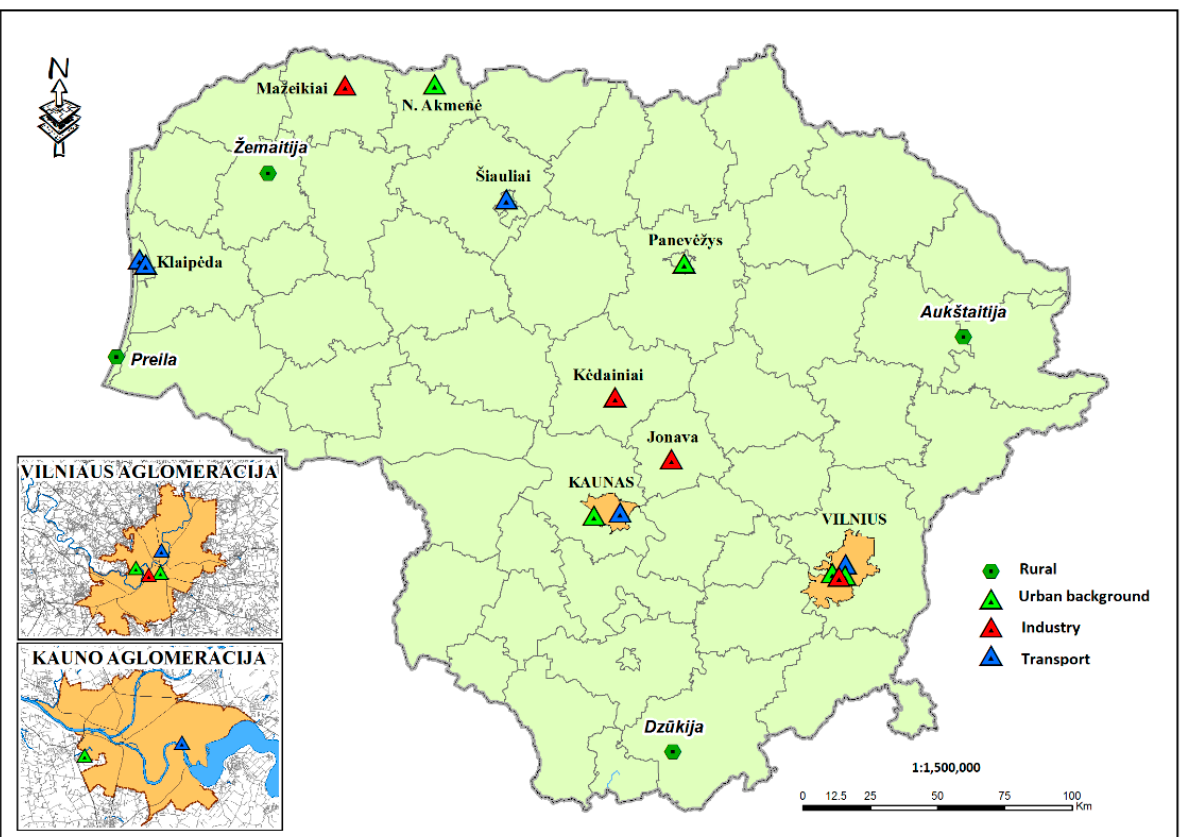
Figure 3. Network of EPA sites representing urban background (green), industry (red), and traffic (blue) environments. The PM 10 data in EPA sites has been analyzed from 2005 to 2020.